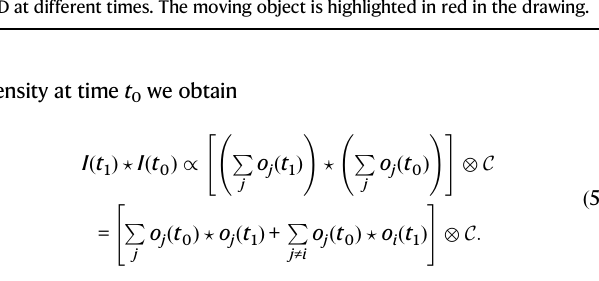
Fig. 2 | Experimental results of tracking moving objects via speckle correla- tionsinthecaseoffewobjectsinthescene.a Displayedintensitypatternsonthe DMD at different times. The moving object is highlighted in red in the drawing.